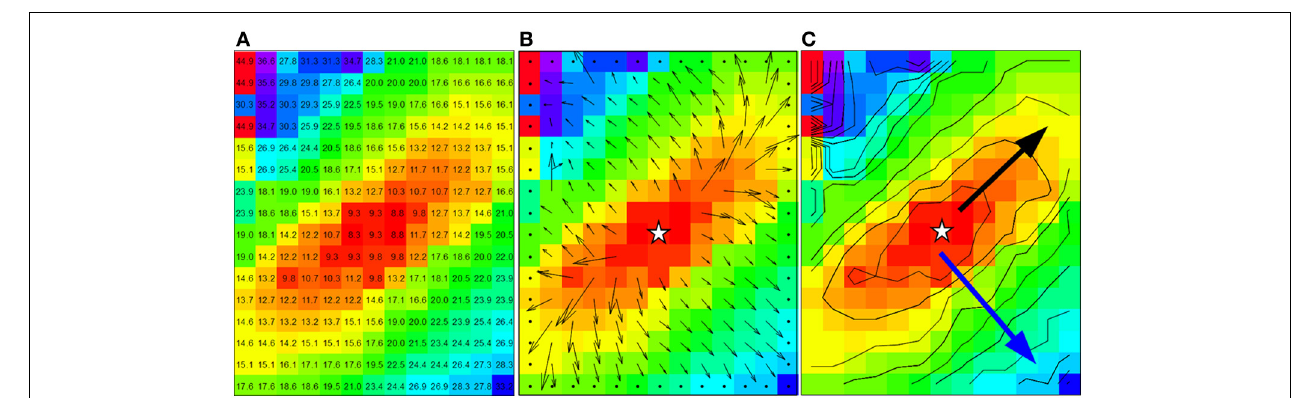
manually selected longitudinal conduction velocity (2.8mm in 6ms, Vl = 0 . 47m/s) and the blue arrow for the transversal conduction velocity (3.2mm in 17ms, Vt = 0 . 19m/s). Star shape in (B,C) indicate the actual stimulus